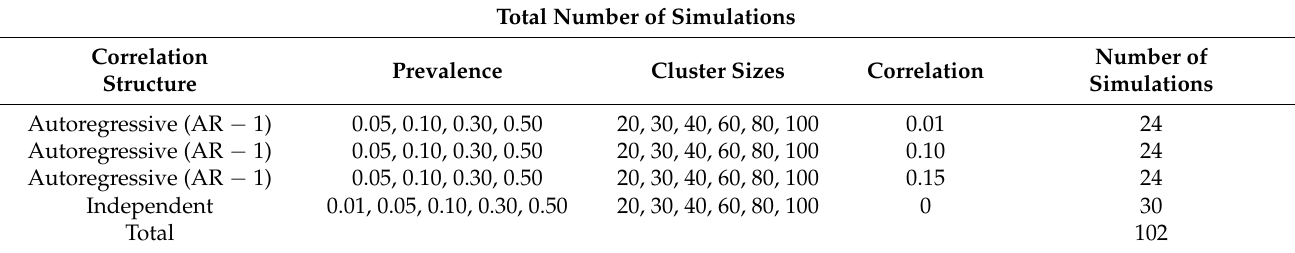
Table 3. Simulation design settings for each of the six estimators. Total Number of